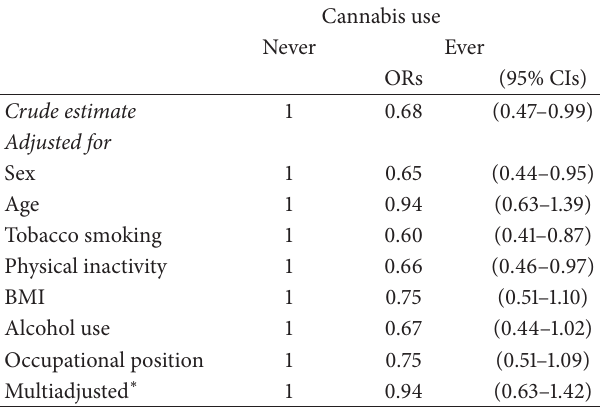
Table 2: Odds ratios (ORs) and 95% Confidence Intervals (CIs) for the association between cannabis use in 2002 and subsequent type 2 diabetes